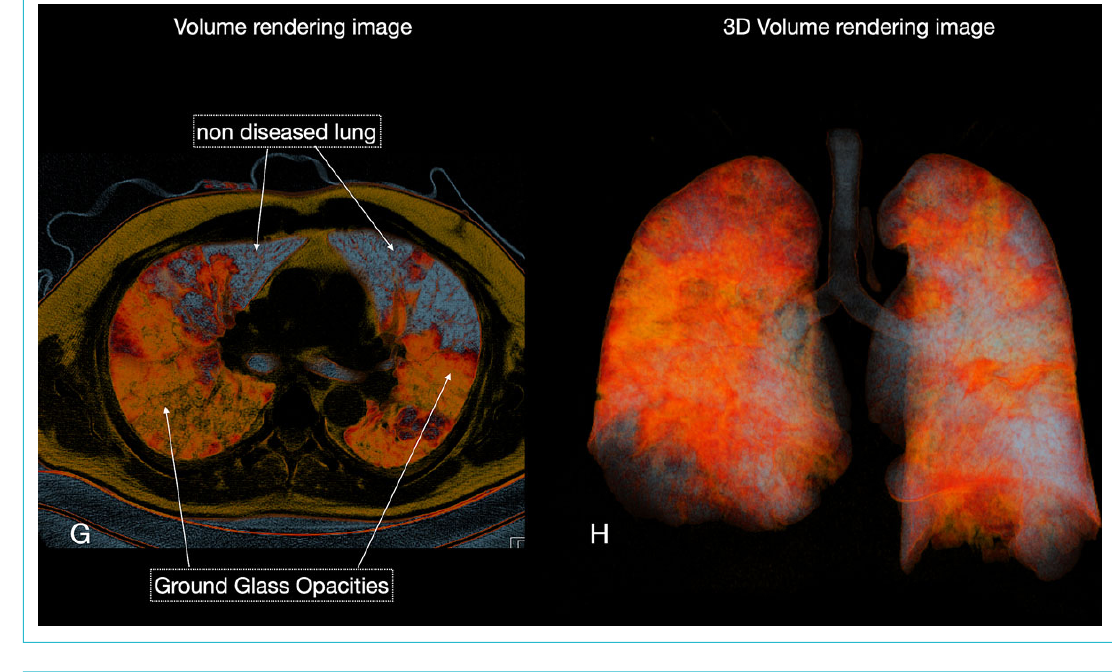
Figure 6 GH: Three-dimensional volume rendering images (H) gave an overview of diseased total lung. The patient required no respiratory assistance.